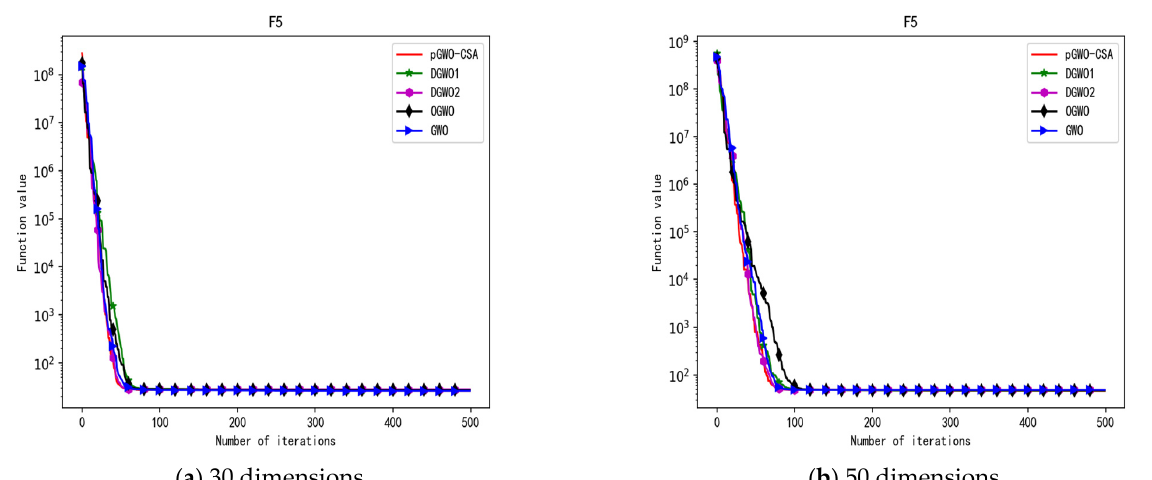
Figure 24. Convergence curve of test function F5.